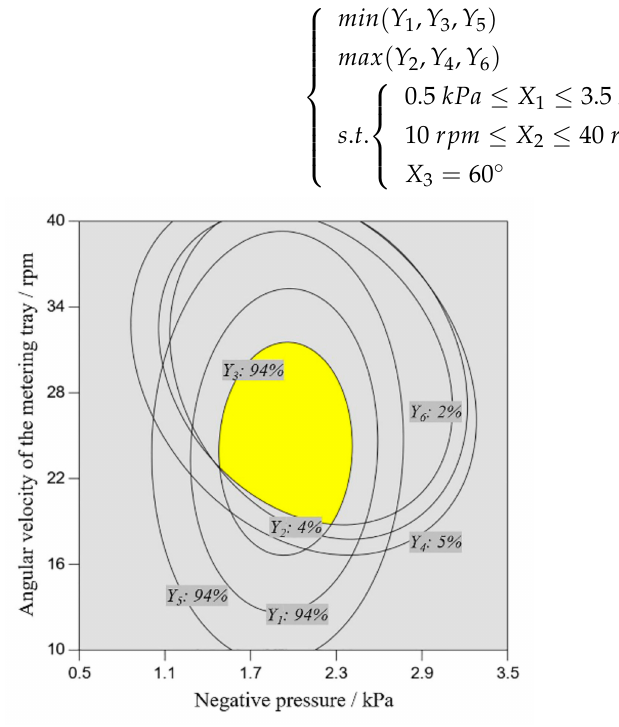
Figure 11. Parameter optimization zone.